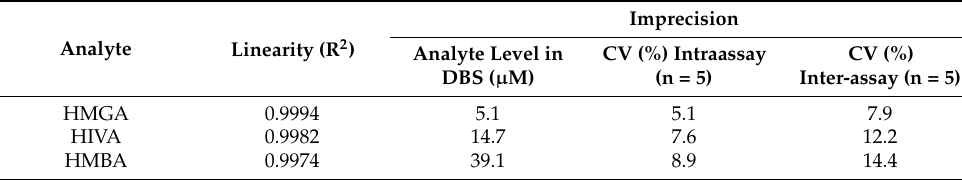
Table 4. Assay validation for HMGA, HIVA, and HMBA analysis.